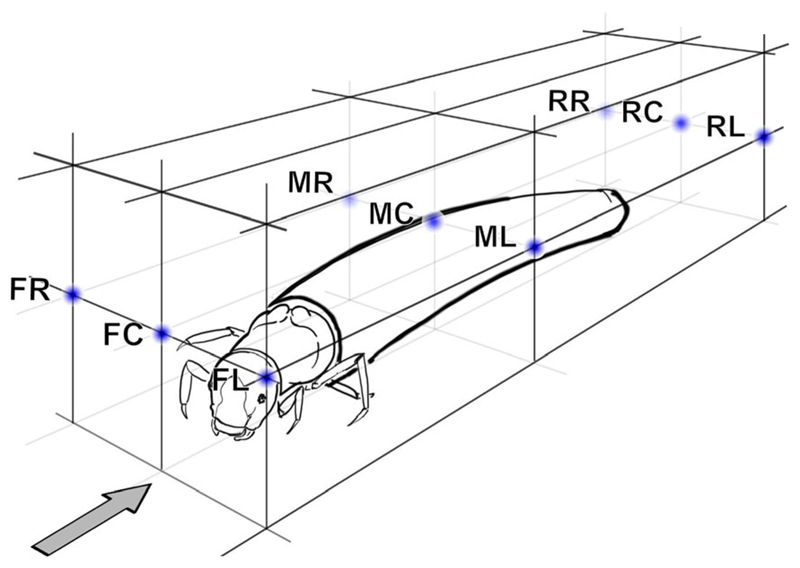
Setup for spatio-temporally filtered flow velocity measurements at the site of a Drusus larva. Acronyms define the positions of the center of the Schiltknecht MiniWater 20 Micro propeller meter used (propeller diameter = 10 mm). Distance between monitoring points FC – FL = 10 mm; distance between front, middle and rear monitoring points vary in accordance with larval length. F front, M middle, R rear, R right, C center, L left, arrow flow direction